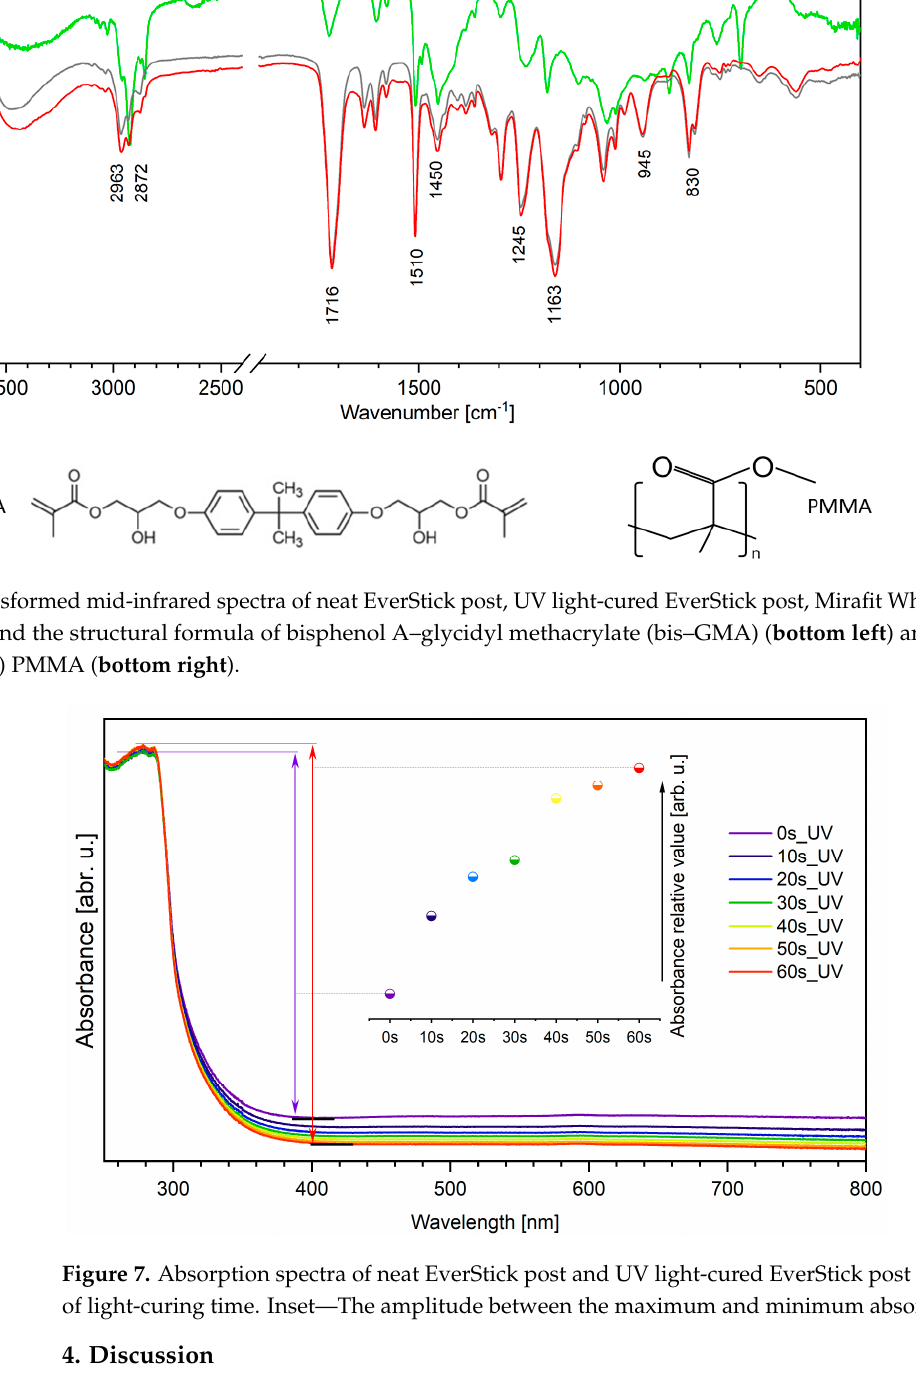
Figure 7. Absorption spectra of neat EverStick post and UV light-cured EverStick post as a function of light-curing time. Inset—The amplitude between the maximum and minimum absorption